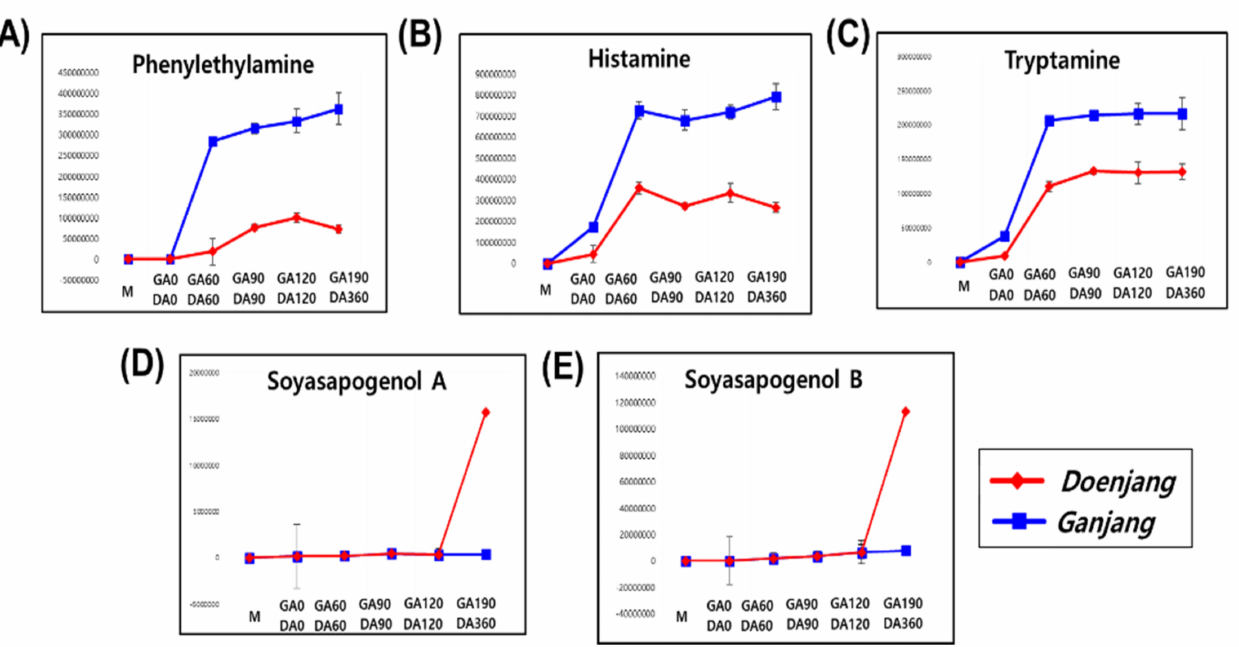
Figure 4. Profiles of biogenic amines (phenylethylamine, ( A ); histamine, ( B ); tryptamine, ( C )), and soyasapogenols (soyasapogenol A, ( D ); soyasapogenol B, ( E )). The Y -axis of the graph indicates peak areas. Differences were considered significant at p -value < 0.05. Data are presented as mean standard error from